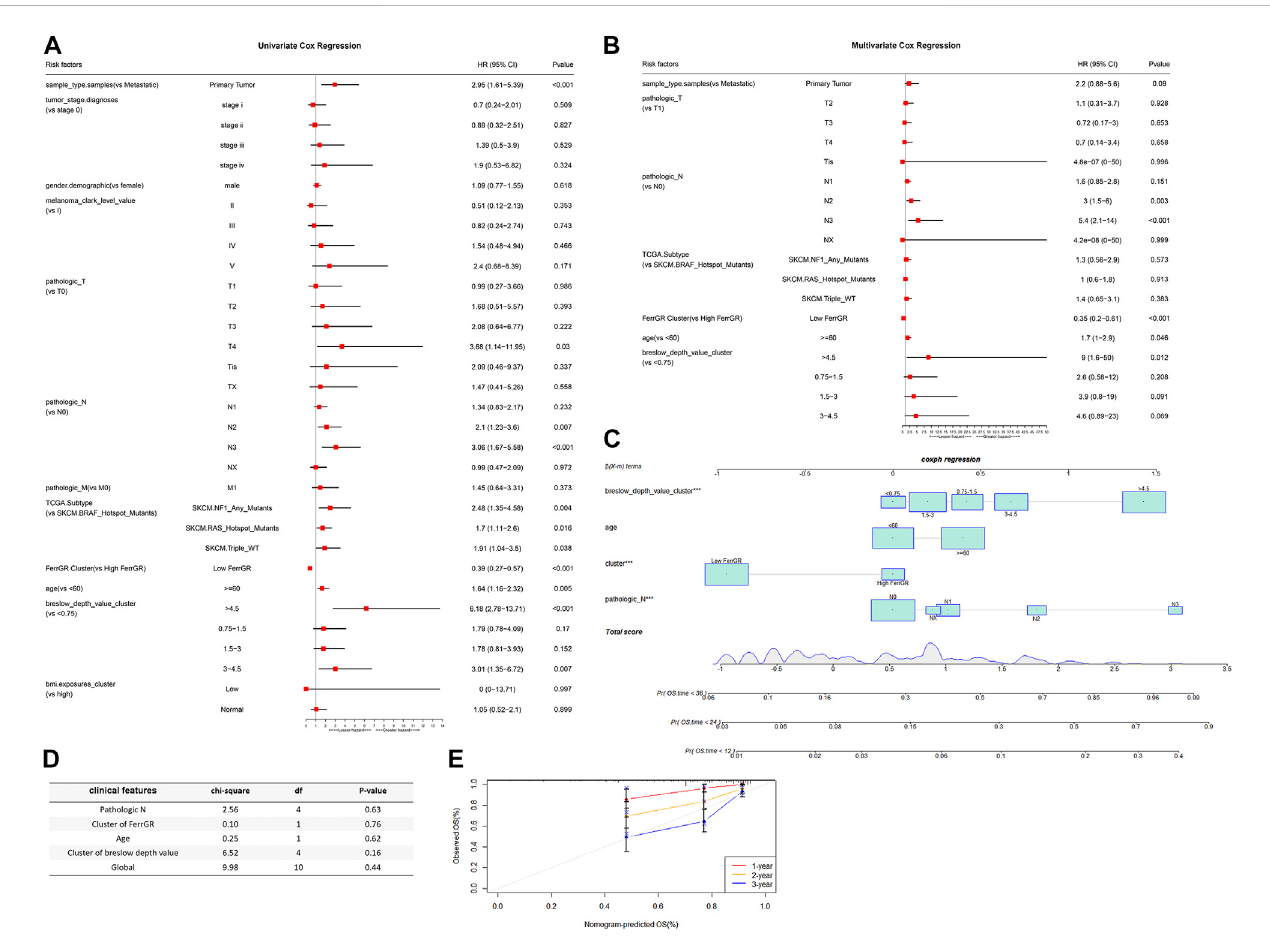
FIGURE 4 TheconnectionbetweenFerrGRscoreandconventionalclinicalcharacteristics. (A,B) UnivariateandmultivariateregressionanalysisofFerrGRscoreand clinical characteristics in prognostic value showed FerrGR score had excellent prognostic independence, (C) Prognostic nomogram for SKCM patients with factors, including Breslow depth value, age, FerrGR score and N stage, (D) Test for the proportional hazards hypothesis, (E) Calibration maps for predicting patient survival at 1, 2, and 3 years. The x-axis and y-axis represent the expected and actual survival rates of the